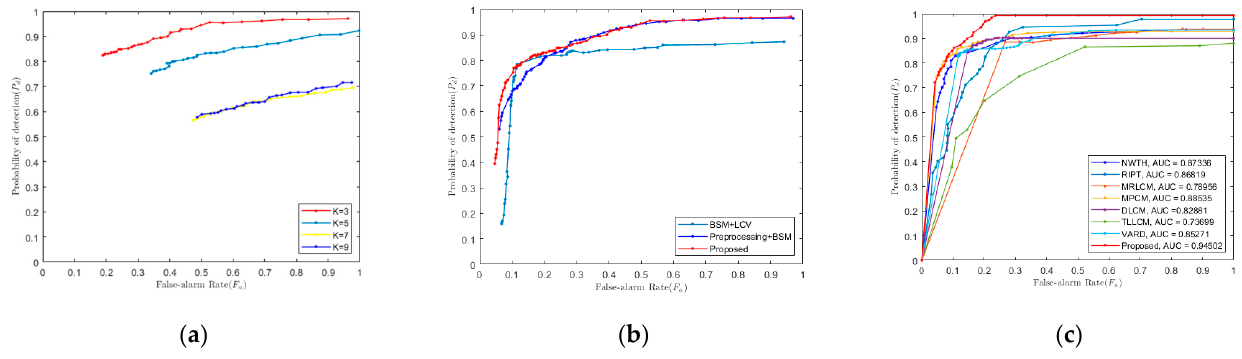
Figure 6. ROC curves. ( a ) ROC curves of SIRST for different K parameters. ( b ) ROC curves of SIRST for different parts of algorithms. ( c ) ROC curves of eight methods in the SIRST dataset.